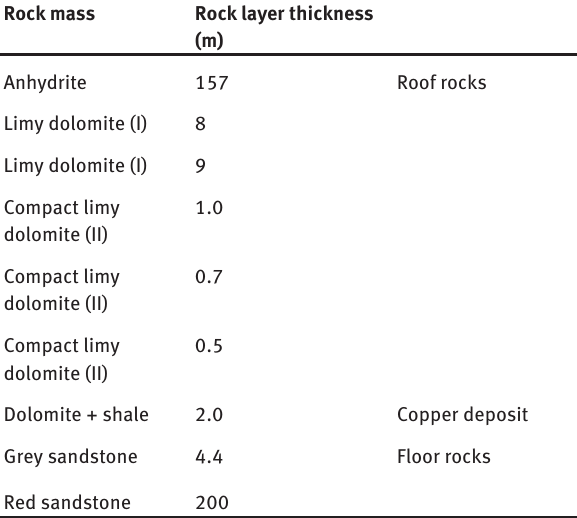
Table 1: Lithology of rock mass in the A5 region.